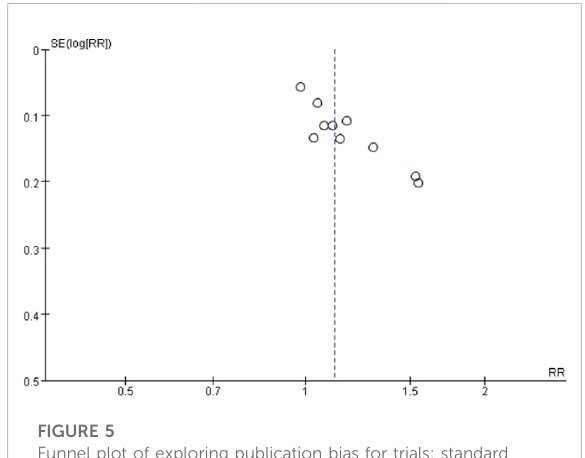
FIGURE 5 Funnel plot of exploring publication bias for trials: standard Tongxie Yaofang versus western medication on the primary outcome